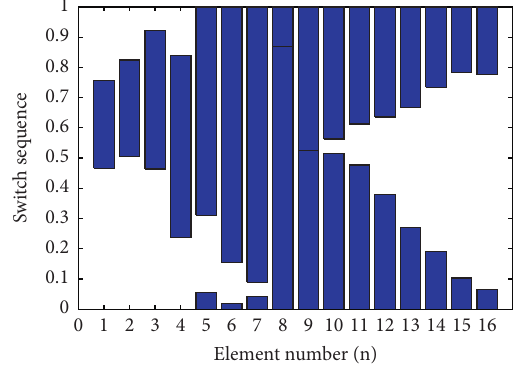
Figure 7: Time series distribution diagram. Table 4: Timing stimulus table.